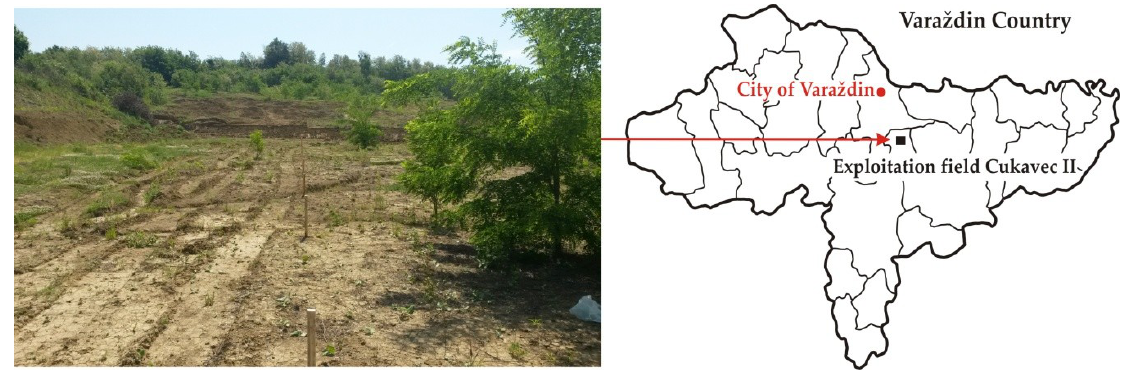
Figure 4. Location of the exploitation field Cukavec II[14].